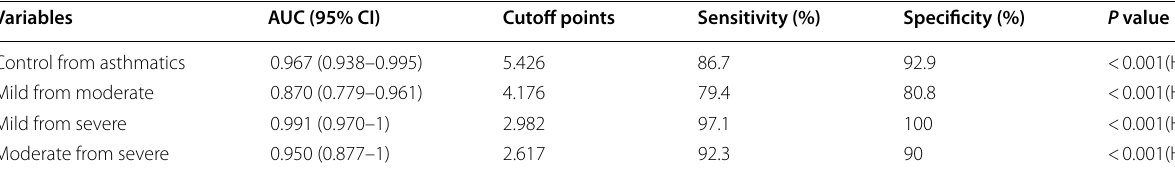
CI: confidence interval, TMEM178: transmembrane protein 178